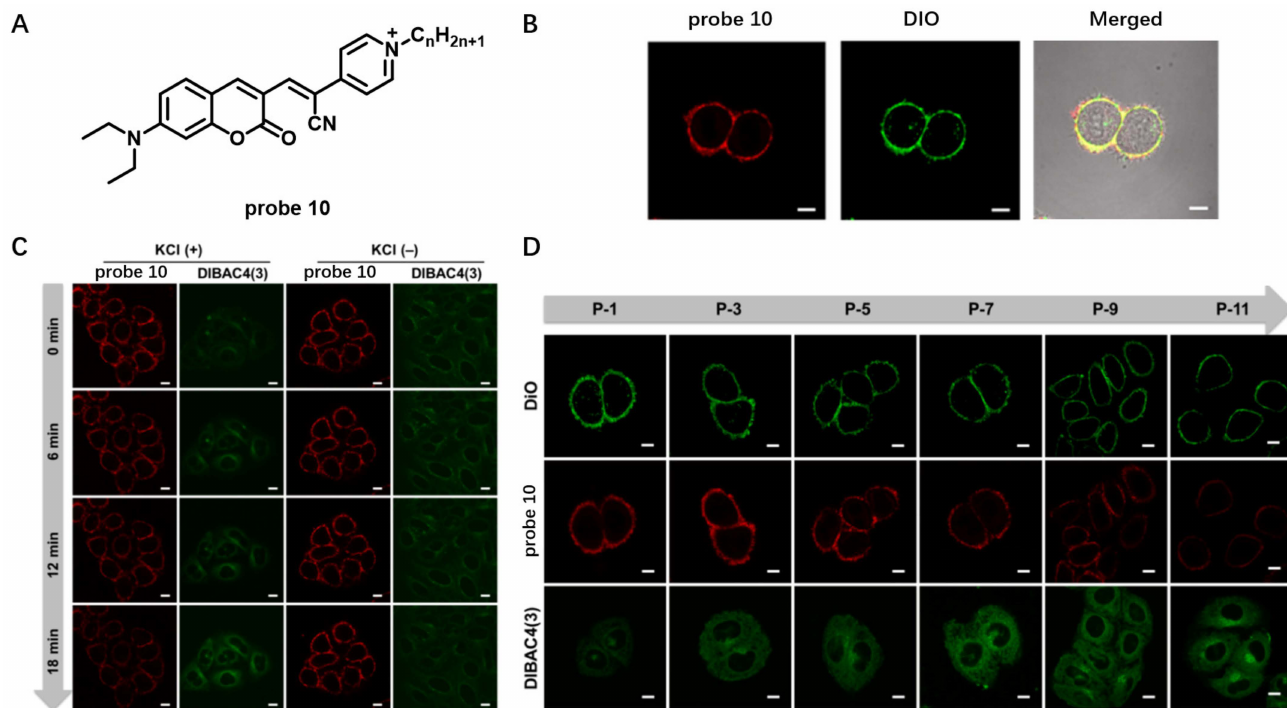
Figure 9. ( A ) Chemical structure of probe 10 . ( B ) CM imaging with probe 10 . ( C ) Fluorescence imaging of the change of ∆Ψ CM using probe 10 . Scale bar: 10 µ m. ( D ) Fluorescence imaging of HeLa cells at different cell passages using probe 10 . Scale bar: 10 µ m. Copyright 2020 American Chemical Society